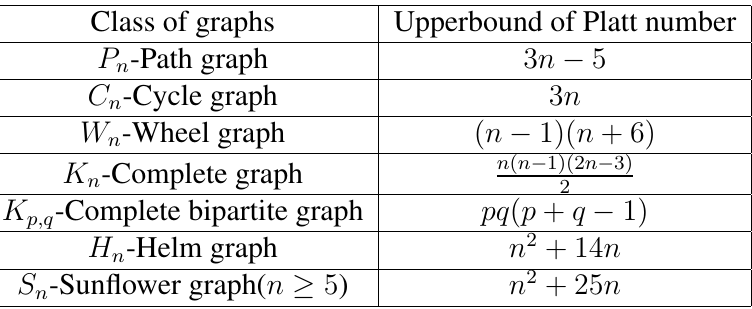
Table 2: Upperbound-Platt